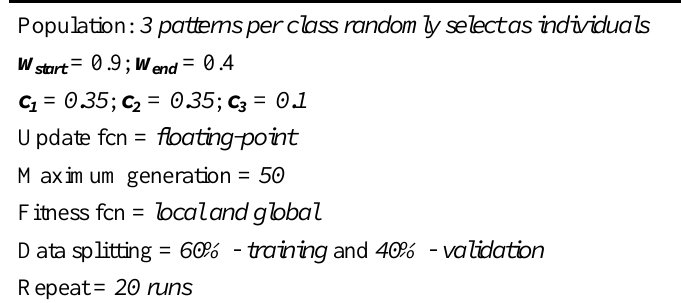
Table 11. The parameter settings of ARAPNN . Population: 3 patterns per class randomly select as individuals